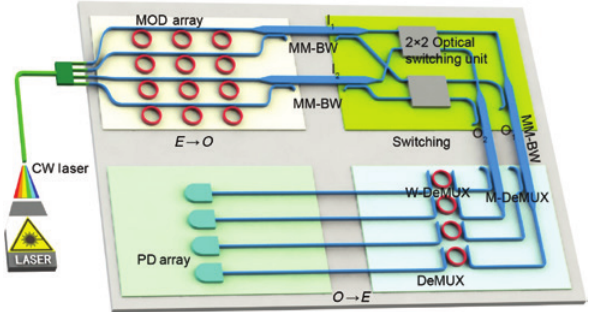
Figure 2: Device realization of the multimode optical switching system-on-chip (SoC) with three wavelength channels and two mode channels. CW, continuous-wave; DeMUX, de-multiplexer; MM-BW, multimode bus waveguide; M-MUX, mode multiplexer; MOD, modulator; PD, photodetector; W-DeMUX, wavelength